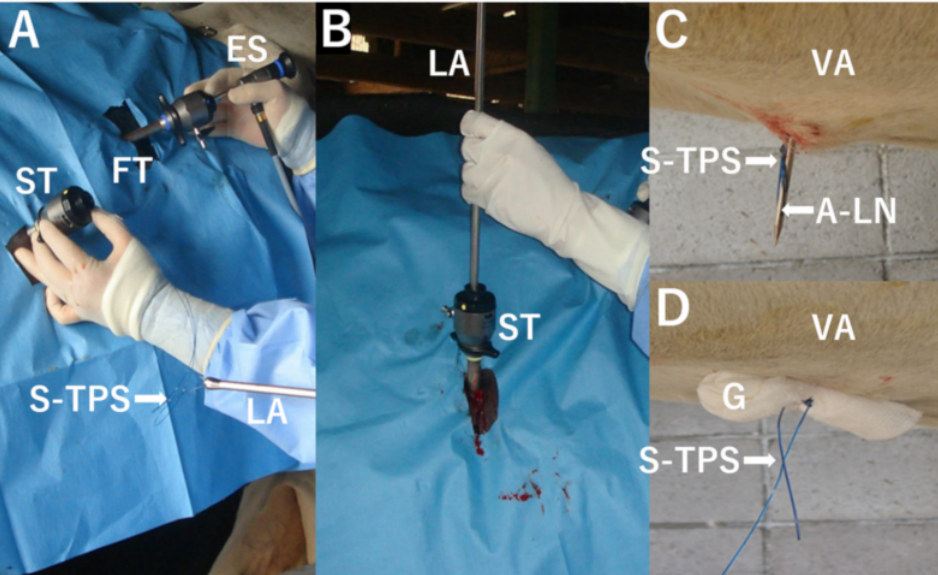
Figure 2. Intraoperative photos of laparoscopic abomasopexy. ( A ) An endoscope (ES) is inserted through a first trocar (FT) introduced into the left flank close to the 13th rib. The suture part of a toggle–pin–suture device (S-TPS), secured to an apex of the needle withdrawn into a long applicator (LA), comes out of a second trocar (ST), introduced into the 11th and 12th intercostal spaces. ( B ) The long applicator (LA) passing through the second trocar (ST) is operated so that the apex of the LA can be advanced toward the ventral abdominal wall under endoscopic observation. ( C ) The apex of the long needle (A-LN), in which the S-TPS is secured, is protruding outside of the ventral surface of the abdomen (VA). ( D ) The S-TPS is tied over a gauze stent (G) in the